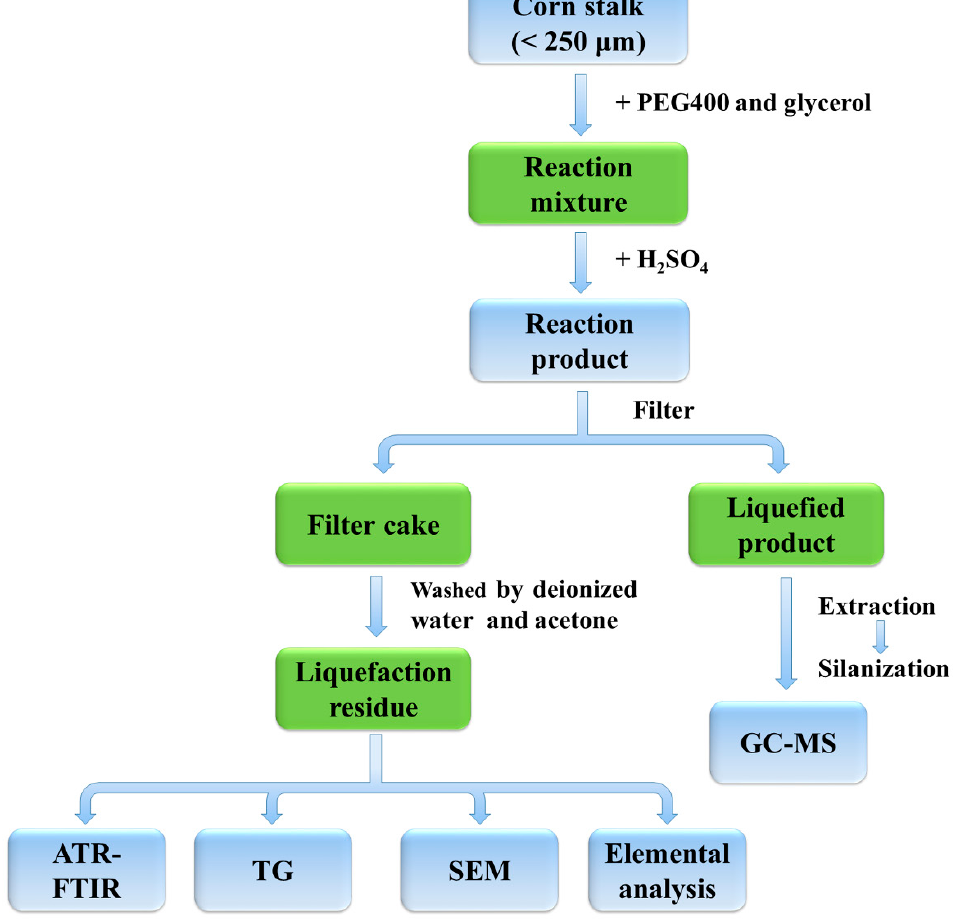
Figure 1. The procedures of the solvolysis liquefaction process and the subsequent characterizations.